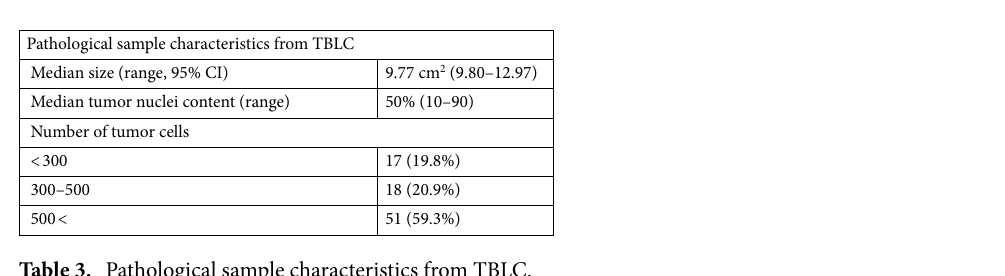
Table 3. Pathological sample characteristics from TBLC.